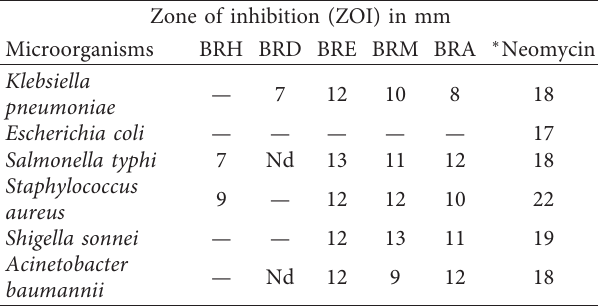
Figure 1: DPPH radical inhibiting capacity of different extracts of B. roxburghiana . Table 4: Antibacterial activity of different extracts of B. roxburghiana